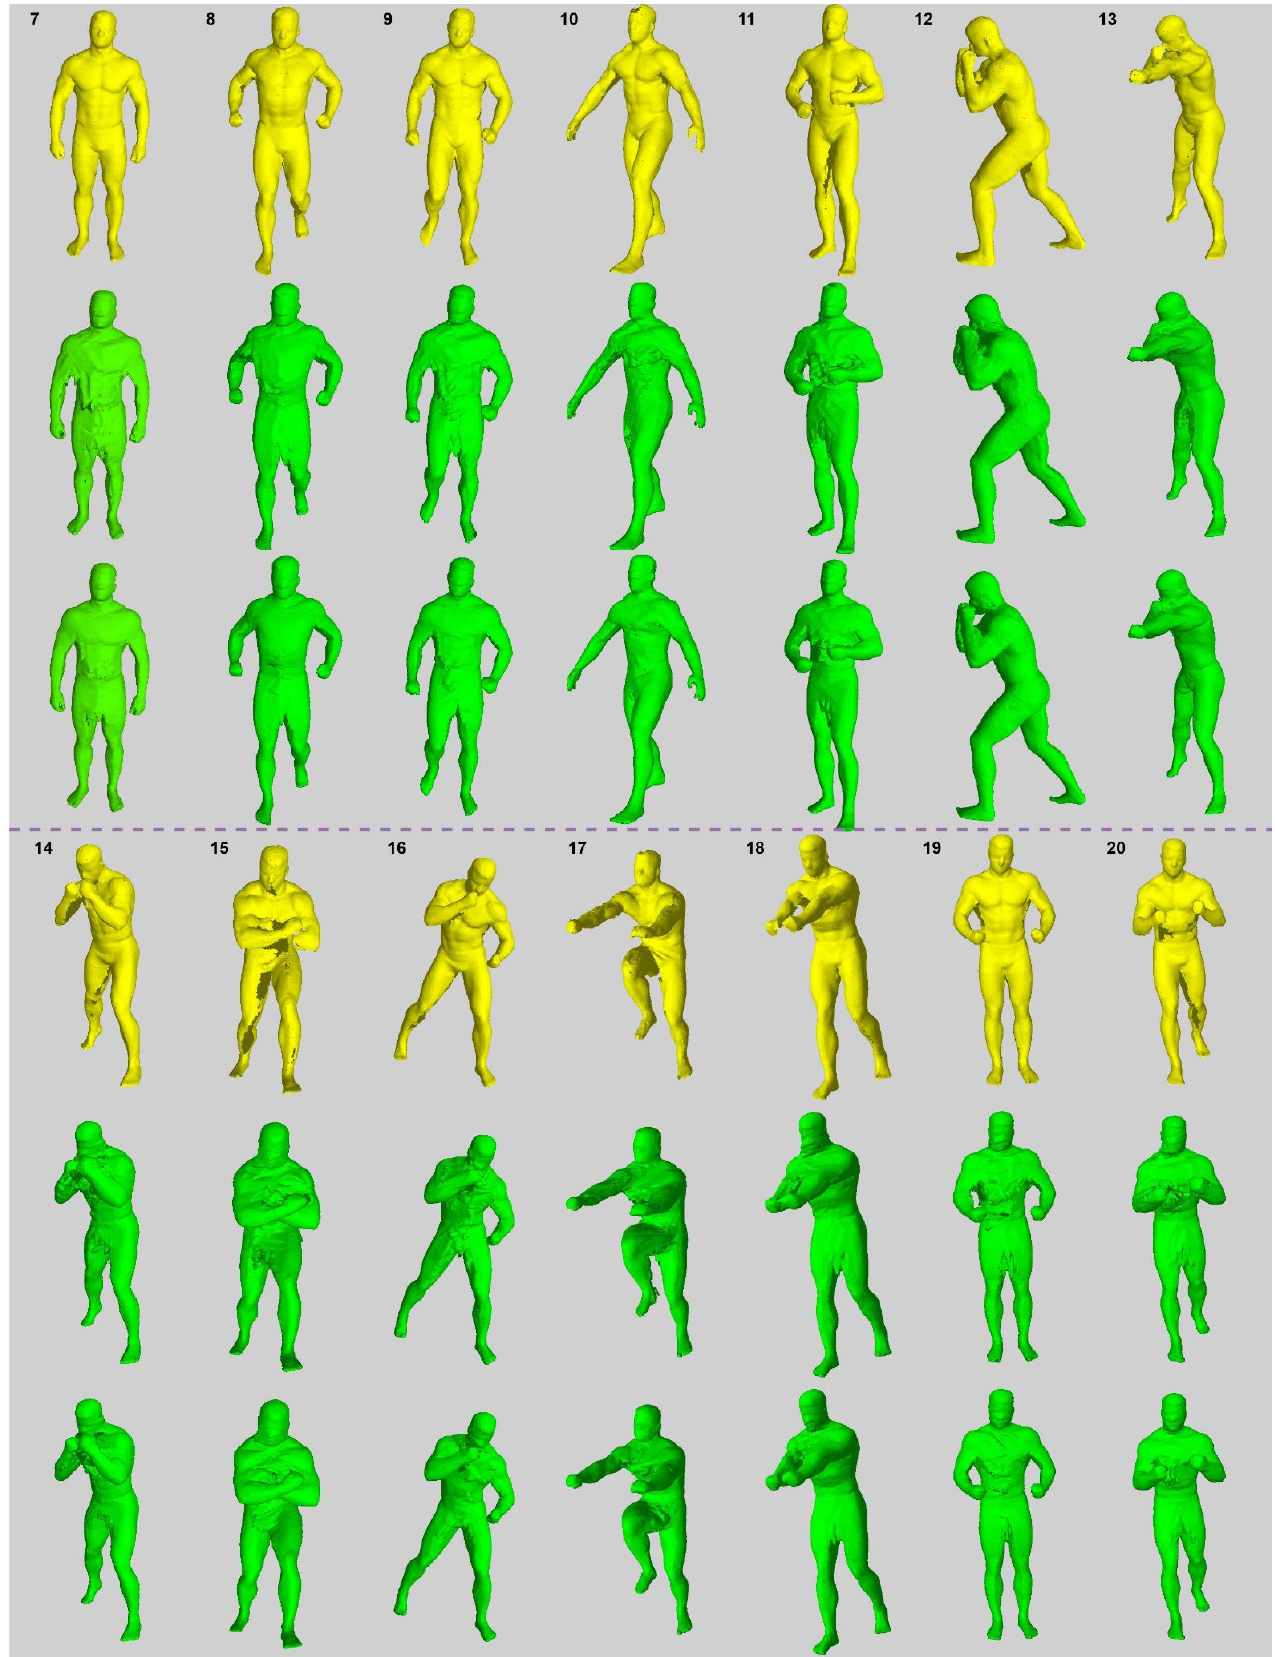
Figure A1. Visualization of the SfS/sSfS reconstructions for data samples #7–#20.